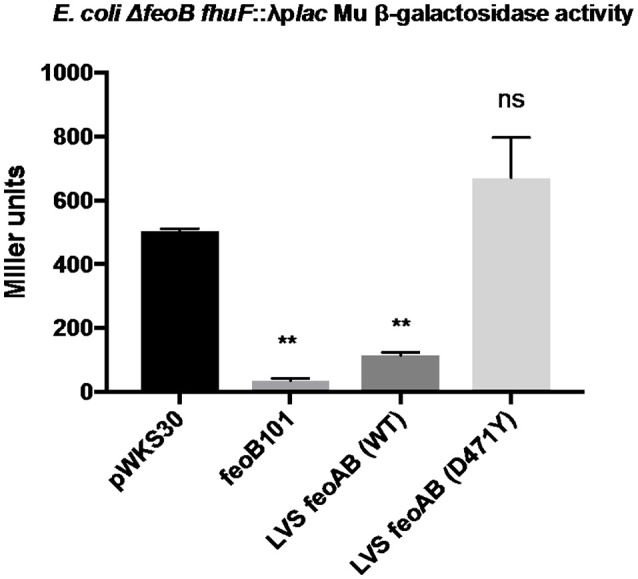
The RML LVS feoB allele is non-functional in a heterologous iron reporter system. The coding sequence of each feoB allele was cloned into the low copy plasmid pWKS30 and introduced to E. coli H1771. The coding sequence of feoA was fused to the groE promoter in a derivative of plasmid pBB103 and supplied to E. coli H1771 in tandem with the feoB expression plasmids, and Miller assays were performed as described in the Materials and Methods. A one-way ANOVA with Dunnett's multiple comparisons test was used to test for significance against the control pWKS30 plasmid. Significance was set at p < 0.05. **Indicates a significant difference between the labeled samples and pWKS30. Shown is a representative experiment from three replicates.